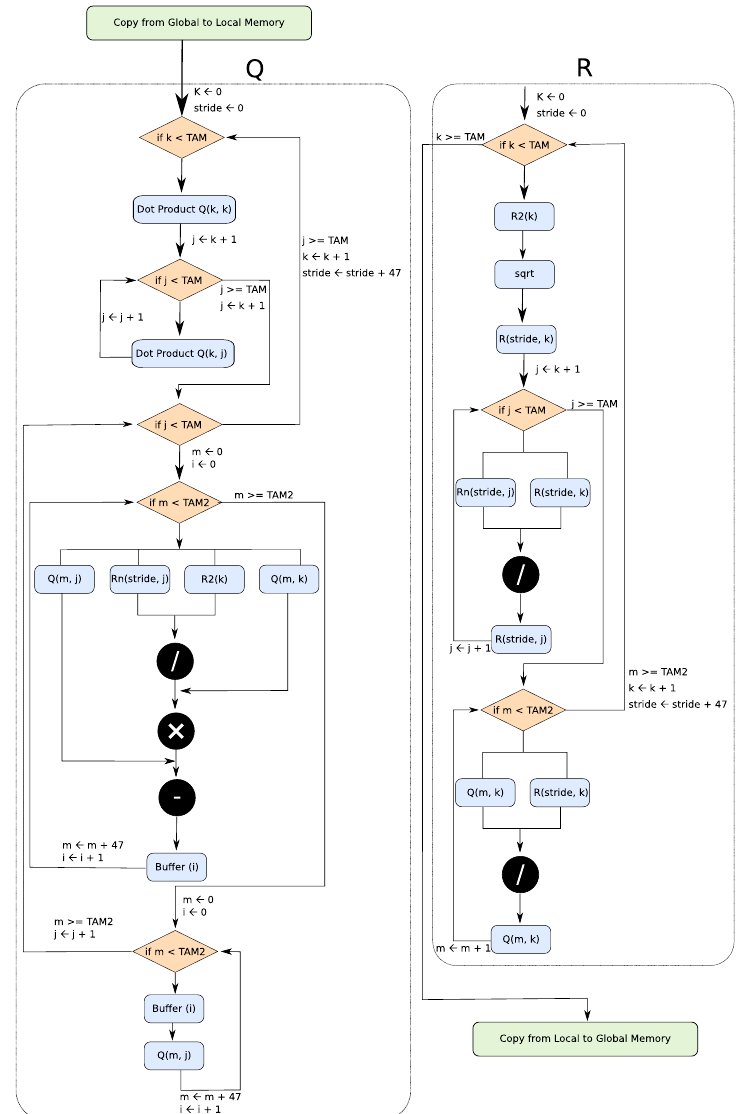
Figure 3. Block diagram of the third version of